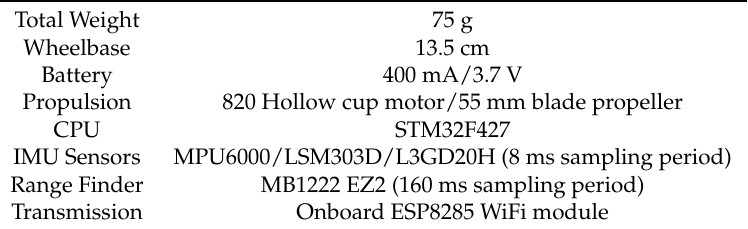
Table 1. Features of Thales II micro air vehicle (MAV)